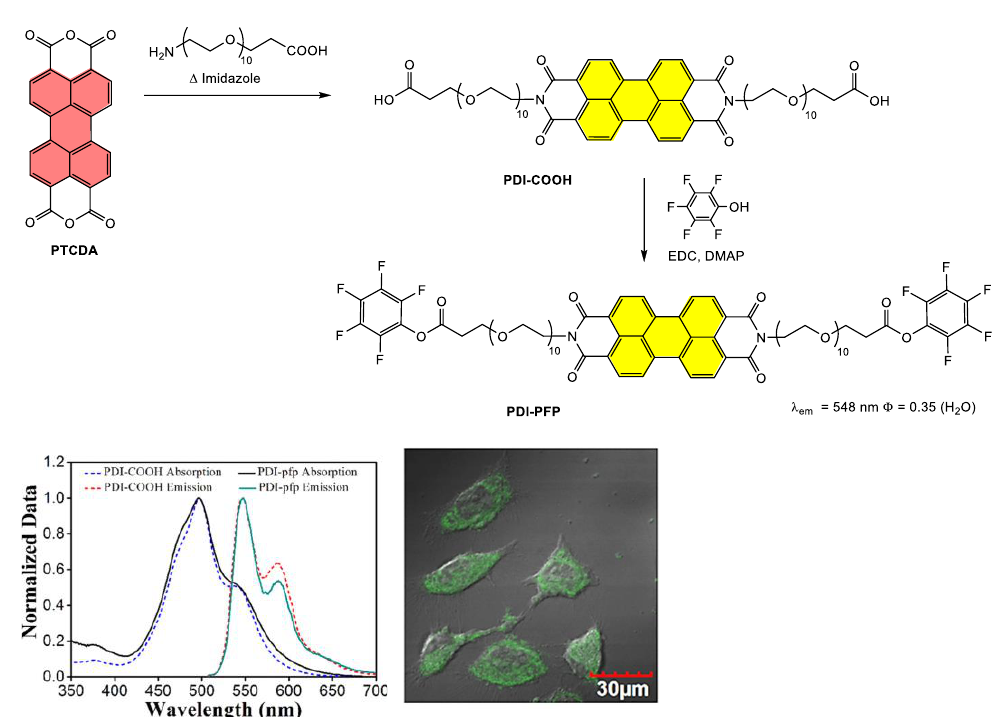
Figure 8. Synthesis of polymer PDI-PFP; UV-Visible and fluorescence emission spectra of PDI- COOH and PDI-PFP in aqueous solution; confocal laser scanning microscopy images of MCF-7 cells incubated with PDI-PFP (10 μm) for 30 min. Reprinted with permission from reference [107]. Copyright 2018 American Chemical Society.